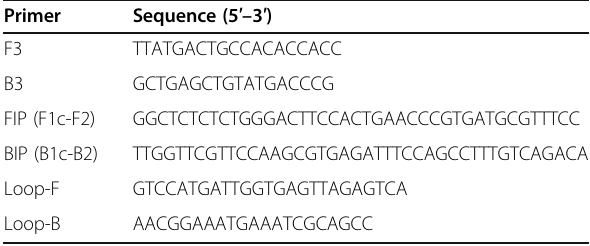
accordance with the nucleotide sequence of ZIKV MR